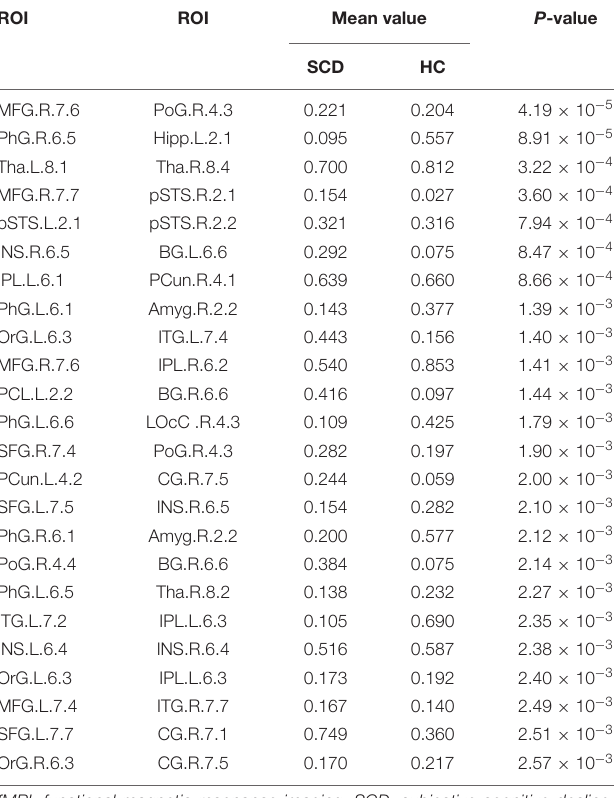
TABLE 5 | Consensus connections identified by the morphological brain network based on sMRI. ROI ROI Mean value P -value